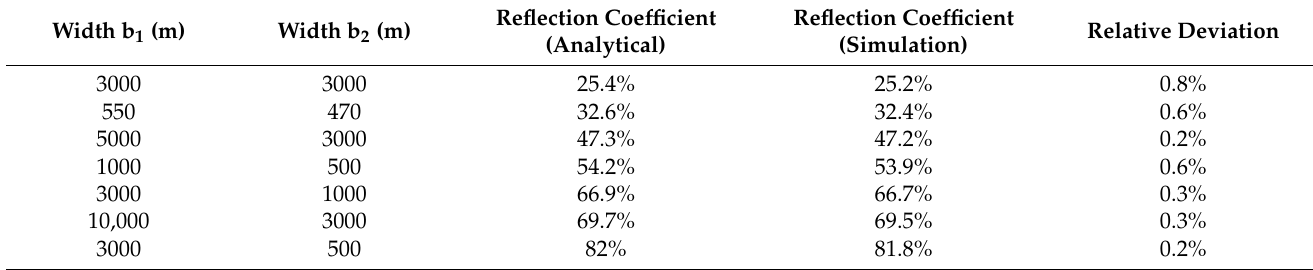
Table 4. Comparison of calculated and simulated coefficients for a depth ratio 17/6 and different width ratios. Width b 1